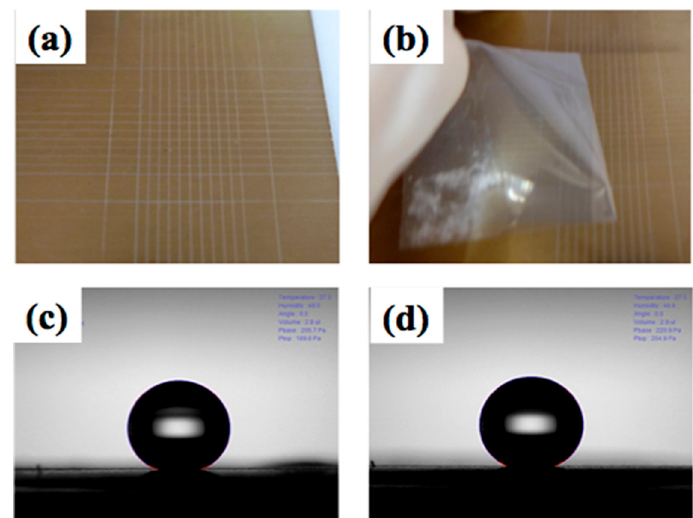
Figure 5. The adhesion test following ASTM standard D 3359-02 method. Optical images of ( a ) cross-cut scratched surface, and ( b ) adhesion test using adhesion tape. The water contact angle of ODTS-coated torched-titanium surfaces; ( c ) before the attachment of adhesion tape, and ( d ) after the attachment and detachment of adhesion tape on the surfaces.